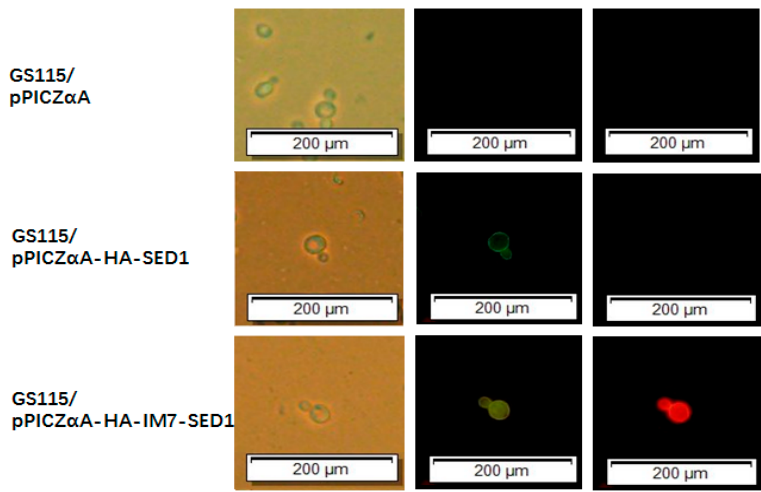
Figure 5. Fluorescence microscopy analysis of P. pastoris yeast cells including GS115 / pPICZ α A (first line), GS115 / pPICZ α A HA-SED1 (second line) and GS115 / pPICZ α A HA-Im7-SED1 (third line). All the cells were treated with (middle row) mouse anti-HA tag monoclonal antibodies together with FITC (fluorescein isothiocyanate)-conjugated goat anti-mouse IgG (H + L) antibodies and with CL7-mCherry (right